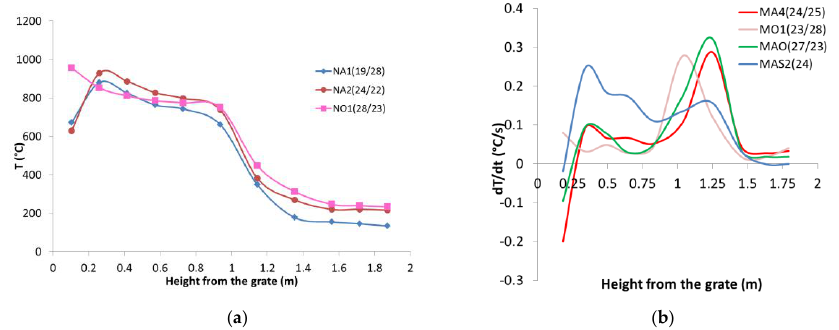
Figure 4. Thermal profile inside the gasifier in the gasification of almond shells (M): ( a ) Temperatures measured in selected tests along the vertical axis ( z ); ( b ) Heating rate of the particles moving downward.